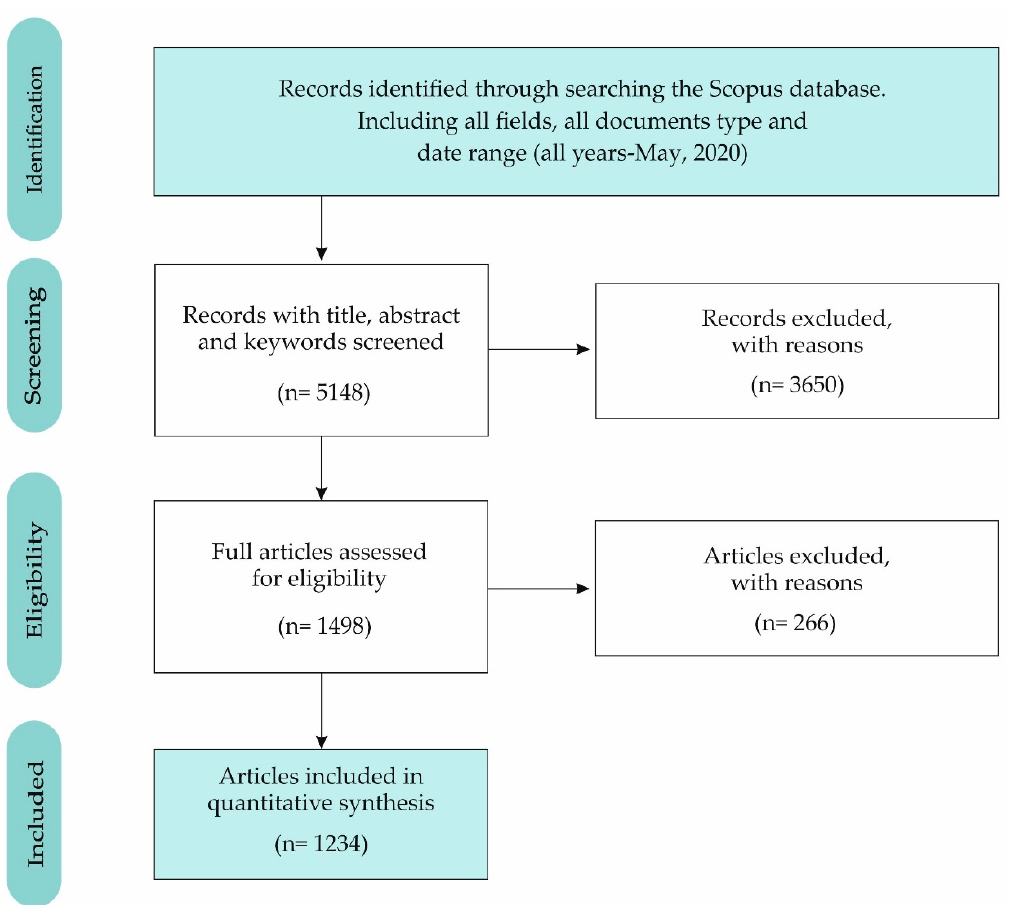
Figure 1. PRISMA flowchart (Preferred Reporting Items for Systematic Reviews and Meta-Analyses (PRISMA)).